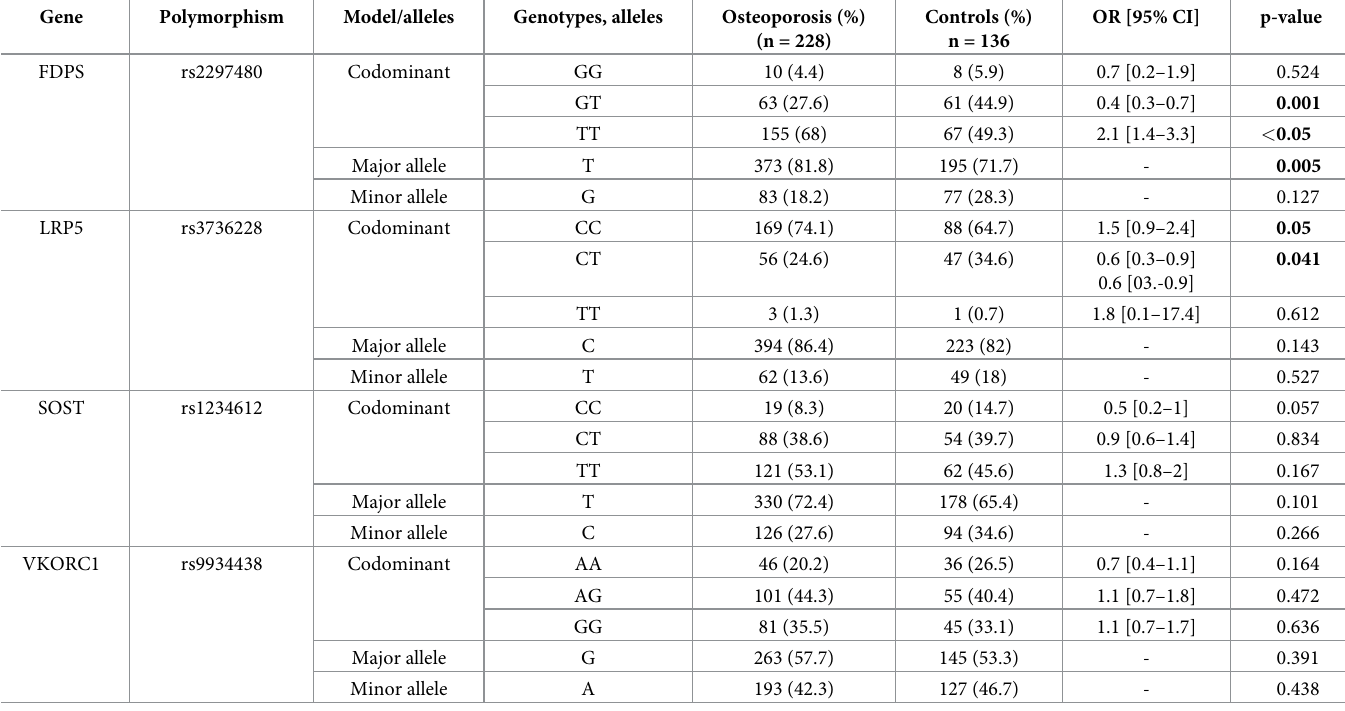
Table 4. Allelic and genotypic distribution between osteoporotic women and controls.